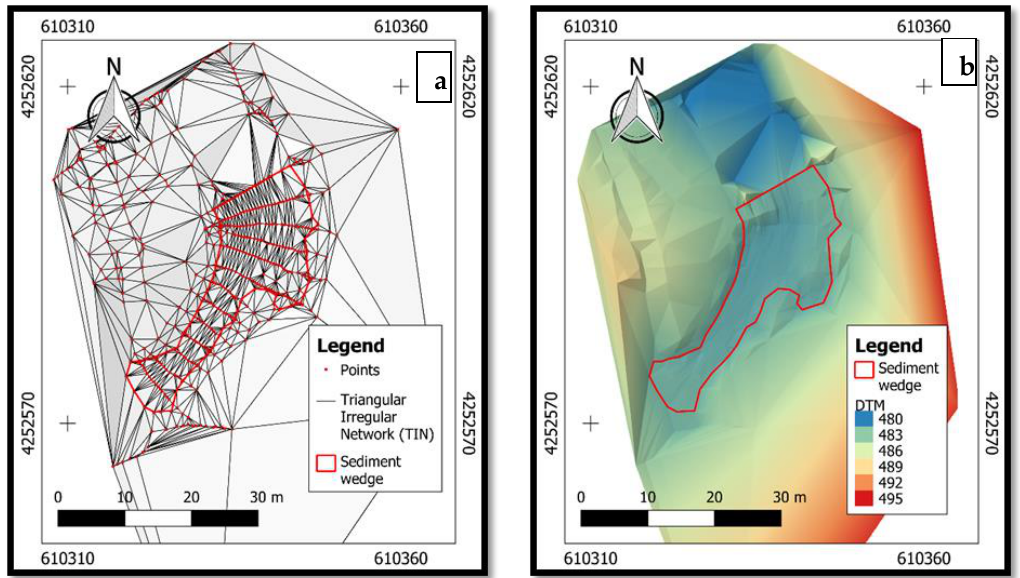
Figure 5. Points and related Triangular Irregular Network (TIN, ( a ) as well as Digital Terrain Model (DTM, ( b ) obtained in the topographic survey for Grillo (number 3) check dam (Sierra de Los Donceles forest, Castilla La Mancha, Spain).